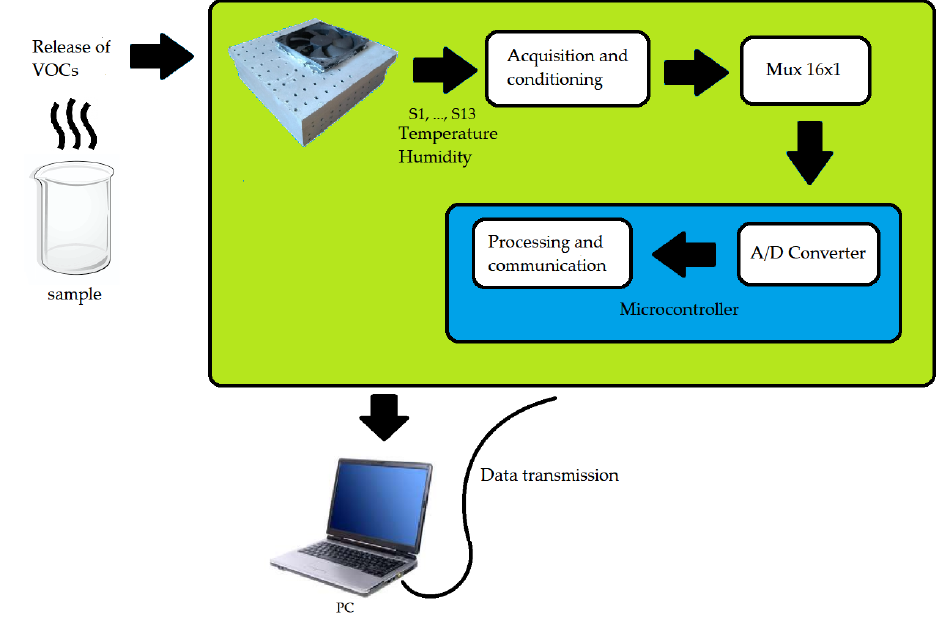
Figure 3. Circuit block diagram.